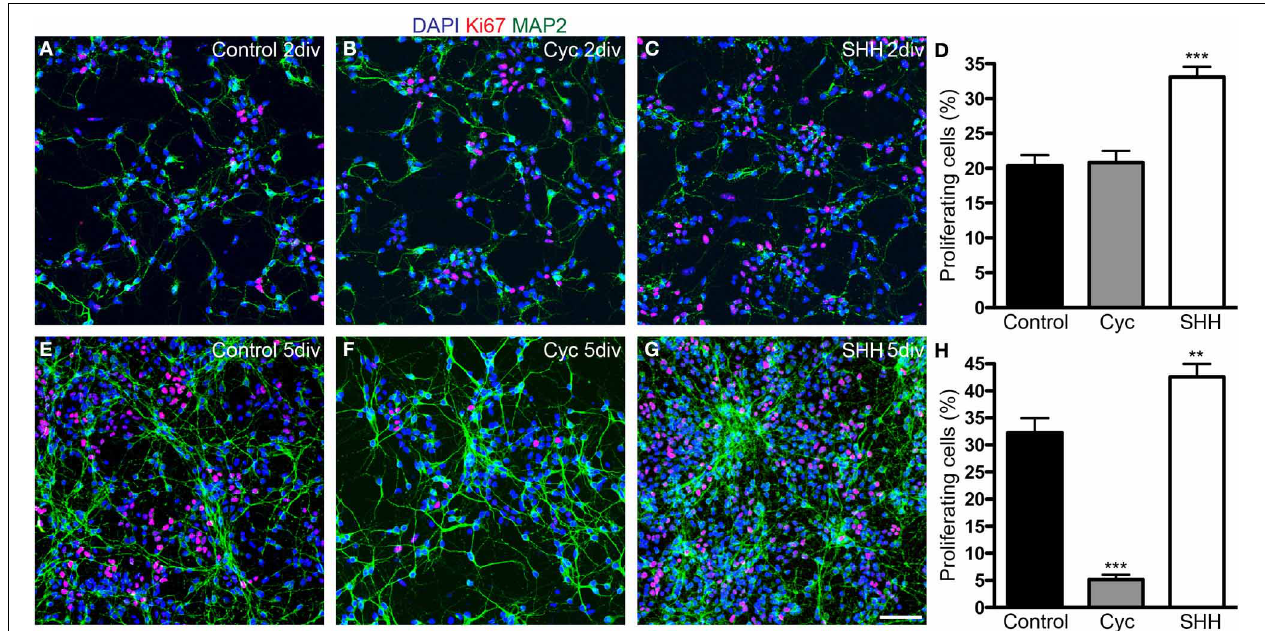
FIGURE 3 | SHH signaling increases the number of proliferating cells. (A–C,E–G) Images of cortical cell cultures after 2 (A–C) or 5 div (E–G) immunolabeled with antibodies against Ki67 (red) and MAP-2 (green). Cell nuclei are stained with DAPI (blue). (D,H) Quantification of Ki67-expressing